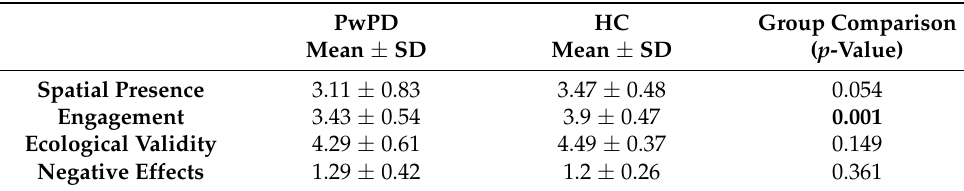
Table 5. Comparison of scores in ICT—SOPI dimensions.